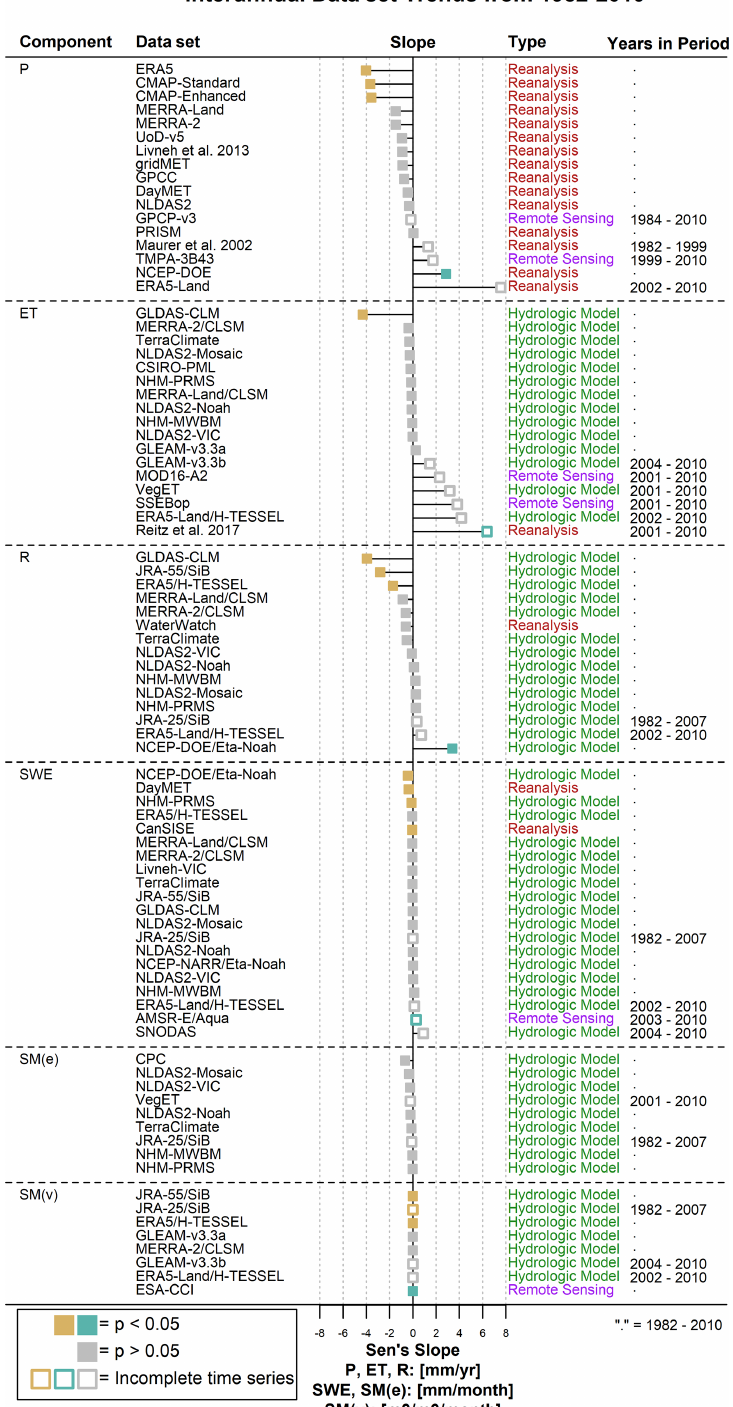
Figure 4. Forest plot of interannual (water year) component estimate Sen’s slope from 1982 to 2010 for components of precipitation ( P ), evapotranspiration (ET), snow water equivalent (SWE), soil moisture in units of equivalent water depth (SM( e )), and soil moisture in units of volumetric water content (SM( v )). Insignificant trends ( p> 0 . 05) are gray. Significant trends are colored based on direction, where negative trends are gold and positive trends are green. Data sets without complete data during the study period are represented with hollow points, and the temporal extent is noted under “Years in Period”